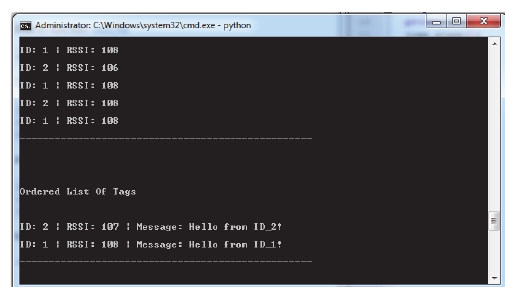
Figure 13: An example of the table of data collected from tags.